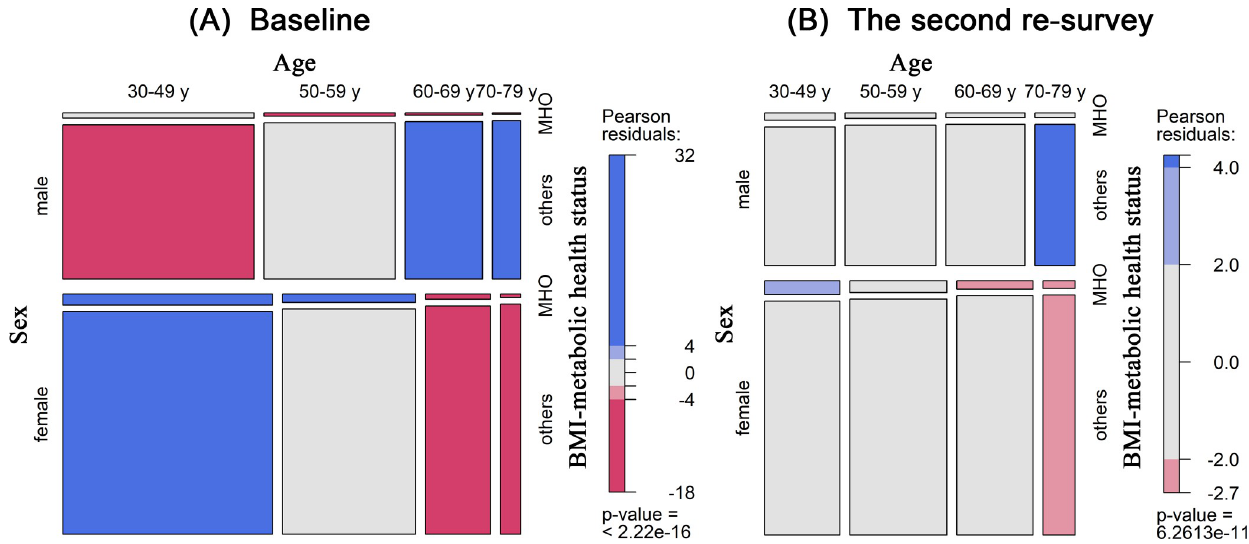
Fig 1. The prevalences of MHO by age and sex. (A) Baseline and (B) the second resurvey. BMI, body mass index; MHO, metabolically healthy obesity.